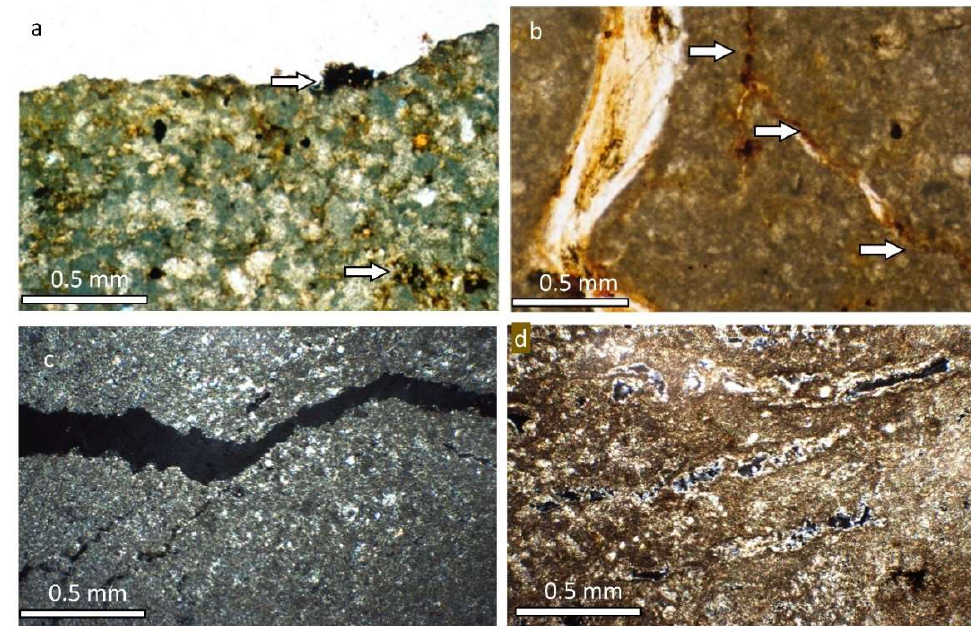
Figure 6. Thin sections of severely burned spalls. ( a ) Weathered chalk surface with charcoal particles attached to the surface, and colonies of endolithic green algae at a depth of 0.5 mm (white arrow); ( b ) weathered chalk with charcoal particles penetrating micro-cracks and roots (white arrows); ( c , d ) fissures in chalk, enlarged by the heat, parallel, and subparallel to the rock surface.